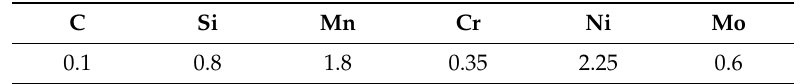
Table 1. Reference analysis of the solid wire Boehler X 90-IG in weight percent, reproduced from [12], with permission from voestalpine Böhler Welding Austria GmbH, 2019.